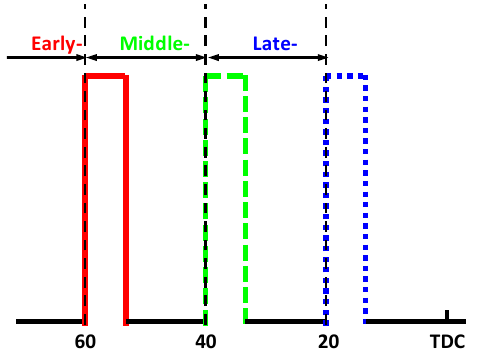
Figure 3. Early injection strategy divided by injection timing.